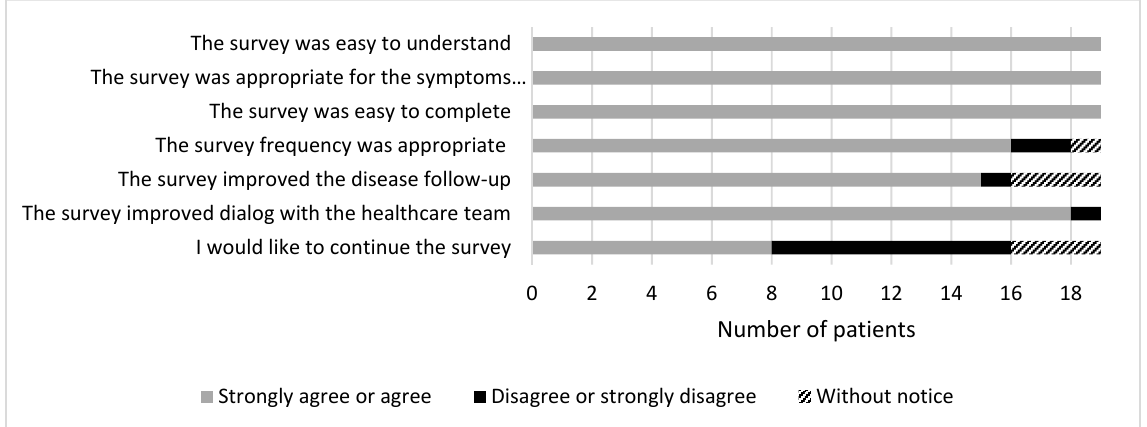
Figure 5. Patient satisfaction survey responses ( n = 19).